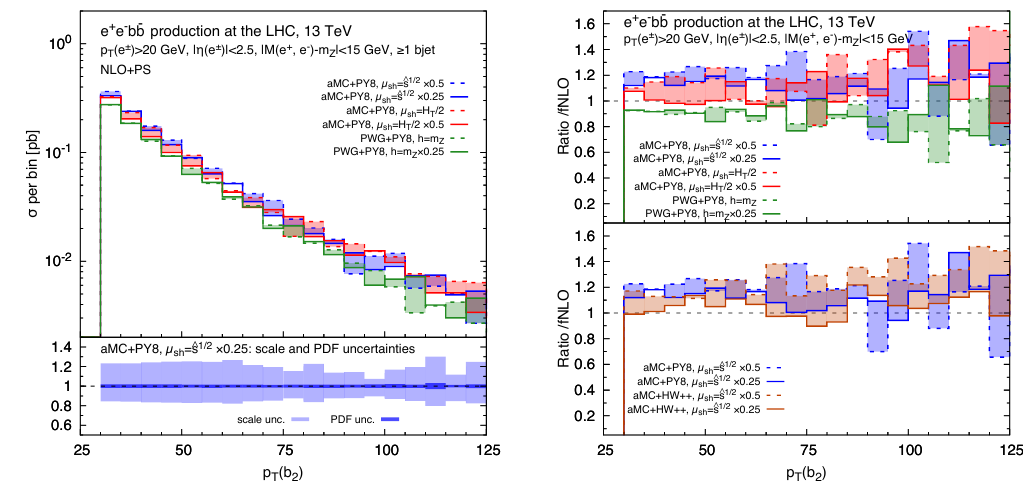
Figure 28 . Transverse momentum distribution of the second-hardest b